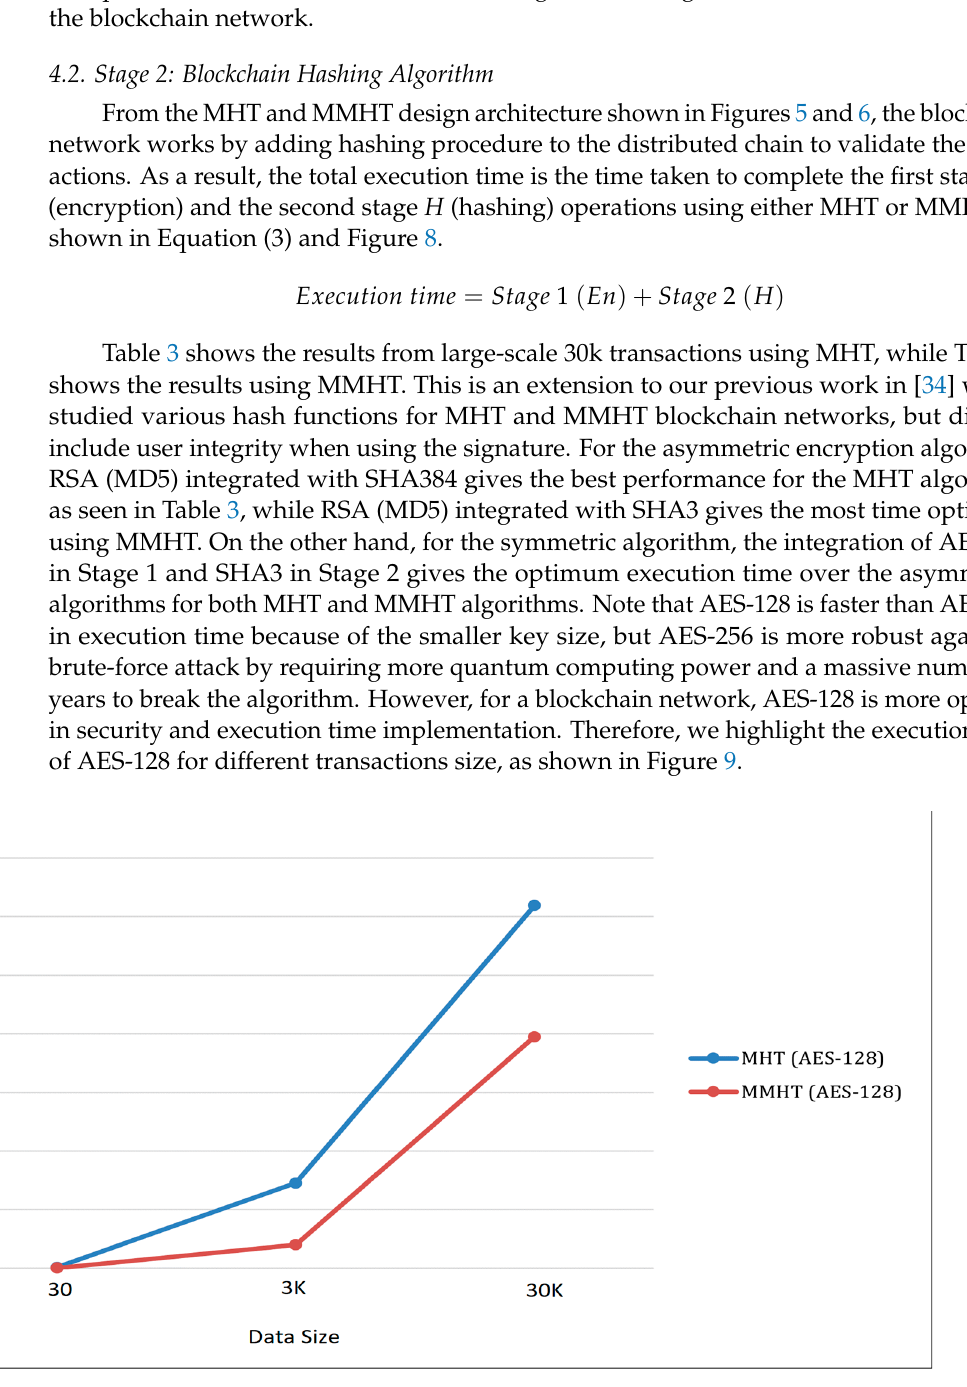
Figure 9. Comparison of hashing execution time (MHT & MMHT) using AES-128 symmetric cipher algorithm with three different dataset sizes.